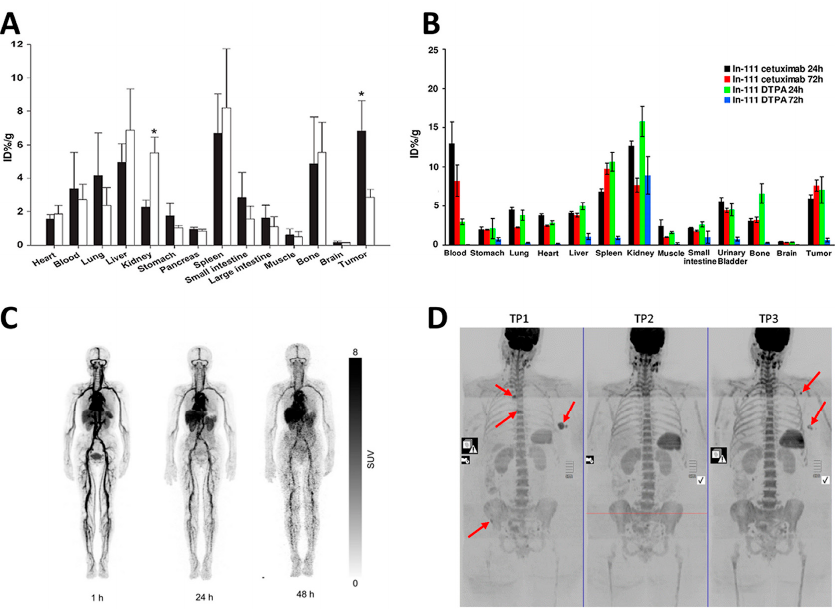
Figure 2. Distribution of monoclonal antibodies into the spleen. ( A ) Tissue distribution of 89 Zr-bevacizumab (black bars) and of 89 Zr-IgG (white bars) measured ex vivo as the percent of the injected dose per gram of weight (%ID/g) in different mouse organs collected 168 h after injection. * p ≤ 0.05 vs. 89 Zr-IgG.Reproduced from [70] with open permission; ( B ) Distribution of 111 In-cetuximab and of diethylenetriaminepentaacetic acid (DTPA) measured ex vivo as %ID/g in organs and in metastatic colorectal tumor radioactivity levels 72 h after the injection. Reproduced from [71] under a Creative Commons Attribution 3.0 License; ( C ) Whole body PET images obtained 1, 24 and 48 h after the injection of 64 Cu-1,4,7,10-tetraazacyclododecane-1,4,7,10-tetraacetic acid (DOTA)-trastuzumab in a patient with HER2-positive breast cancer. Notice the strong accumulation of the labeled antibody in the spleen at all of the time points. Reproduced under a Creative Commons Attribution License from [86]; ( D ) Splenic enlargement in a patient receiving trastuzumab emtansine for the treatment of metastatic breast cancer. Whole body MRI images obtained in a 59-year-old patient with metastatic breast cancer at baseline (time point 1: TP1) and after eight (time point 2: TP2) and 12 cycles (time point 3: TP3) of treatment with trastuzumab emtansine. Notice the progressive enlargement of the spleen whose estimated volume increased from 92.3 cm 3 at baseline up to 214.9 cm 3 at TP3. The arrows indicate the primary breat cancer and bone metastases. Reproduced from [78] with permission from the